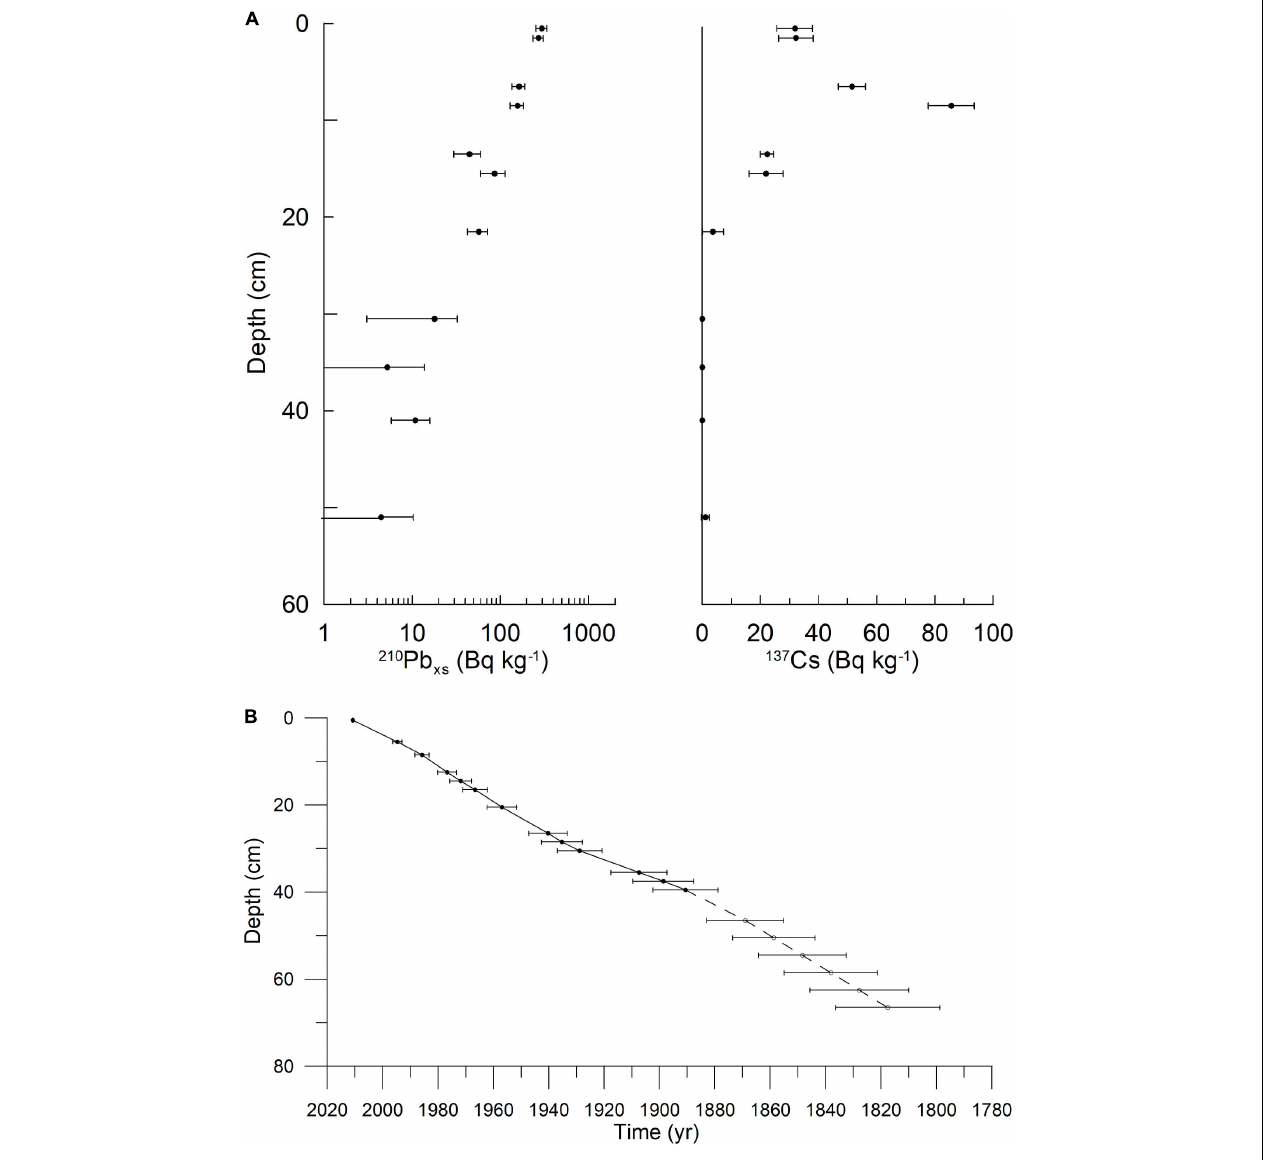
FIGURE 2 | (A) Activity of 210 Pb (left) and 137 Cs (right) with depth. These data were used to create the age-depth model. (B) Age-depth model. Both for the core from Koljö Fjord KF12/5.